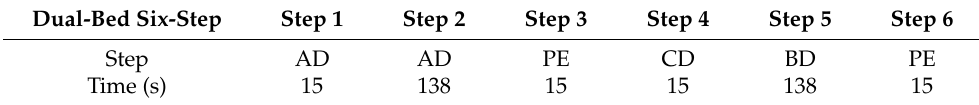
Table 6. Adsorption bed parameters and operating conditions for the basic case. Parameter